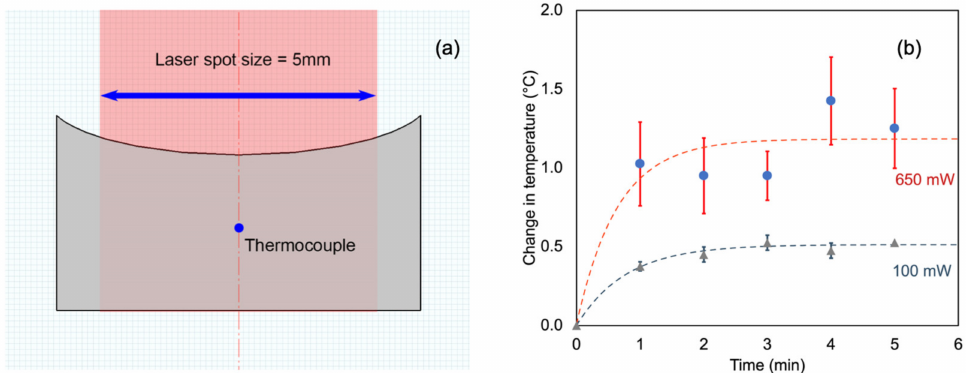
Figure 1. ( a ) Schematic representation of the position of the thermocouple. ( b ) The increase in temperature (from room temperature) measured when exposing the thermocouple to the laser in air. An exponentially decaying heating model has been fitted in each case to guide the eye (n = 4). The absorption and scattering of the laser beam by the thermocouple are potential complicating factors. The absorption of energy by the thermocouple was tested first in the air at 100 and 650 mW (Figure 1b). Since there was only about a 0.5 ◦ C increase in the temperature of the thermocouple in the 100 mW case, the thermocouple was left in place for the 30 µ L experiments. The net ∆ T was obtained by subtracting the temperature rise obtained for a control consisting of a well containing only pure water and the thermocouple. In the case of the 100 µ L experiments (which were carried out at 650 mW), irradiation was applied for 5 min without the thermocouple present, and the thermocouple was introduced the instant the laser was switched